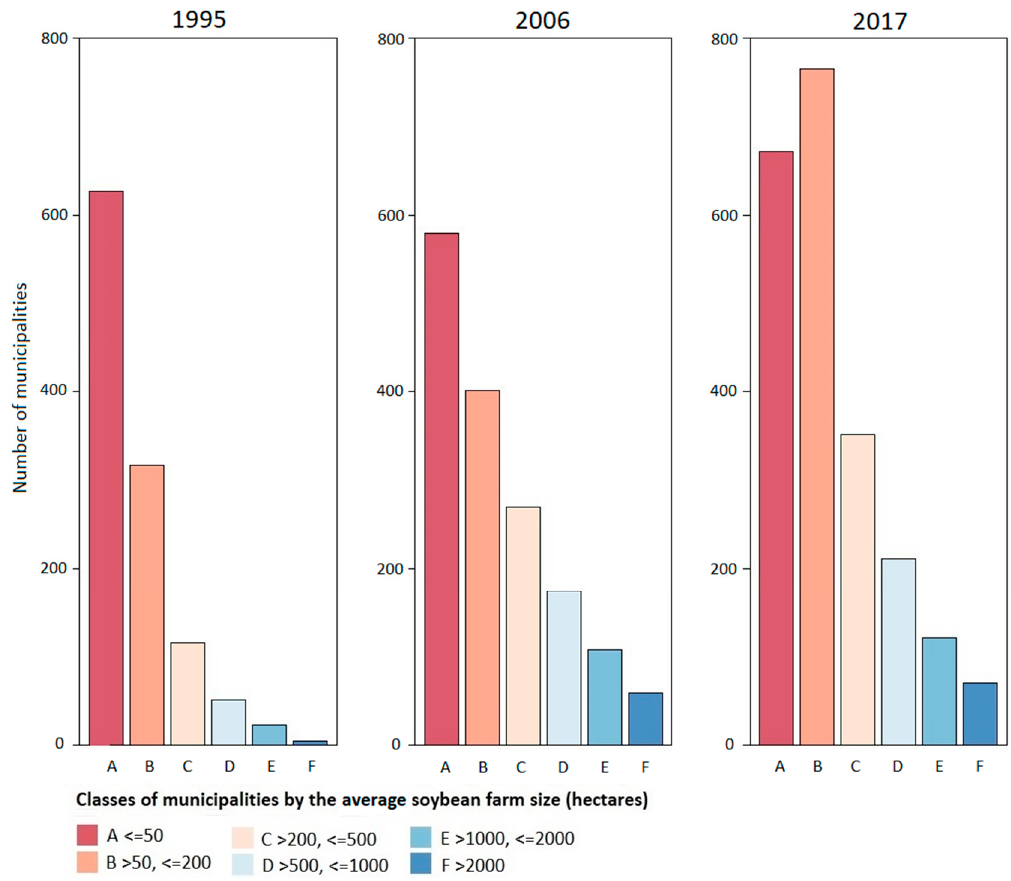
Figure 1. Distribution of municipalities per classes of average soybean farm size in 1995, 2006, and 2017 for all Brazilian municipalities.